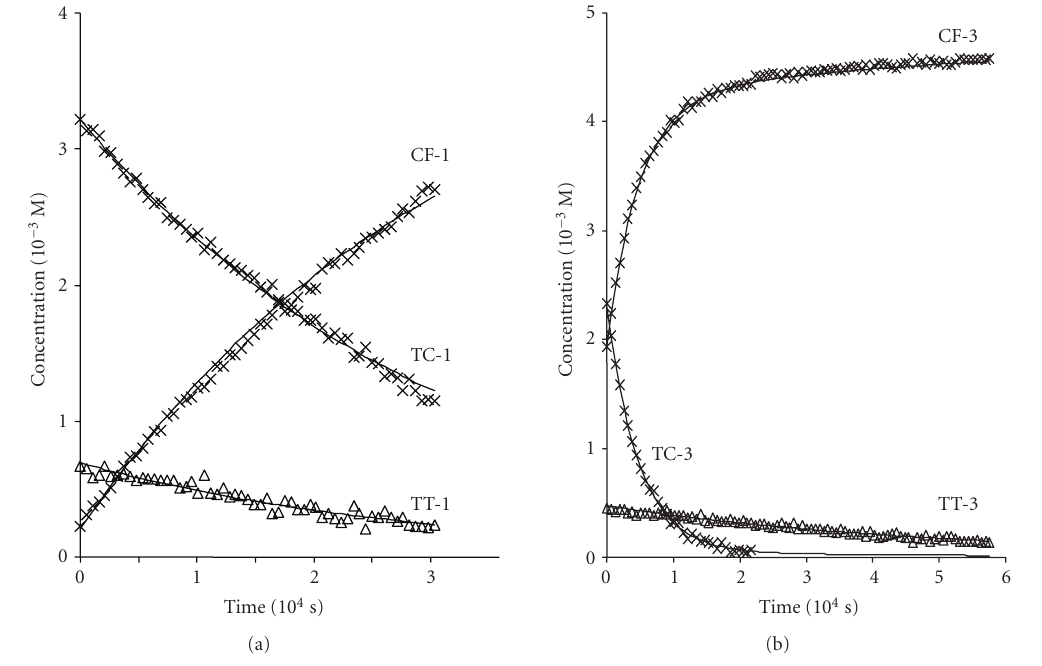
Figure 3: Time-evolution concentrations of CF-1 and CF-3 after UV irradiation at 223